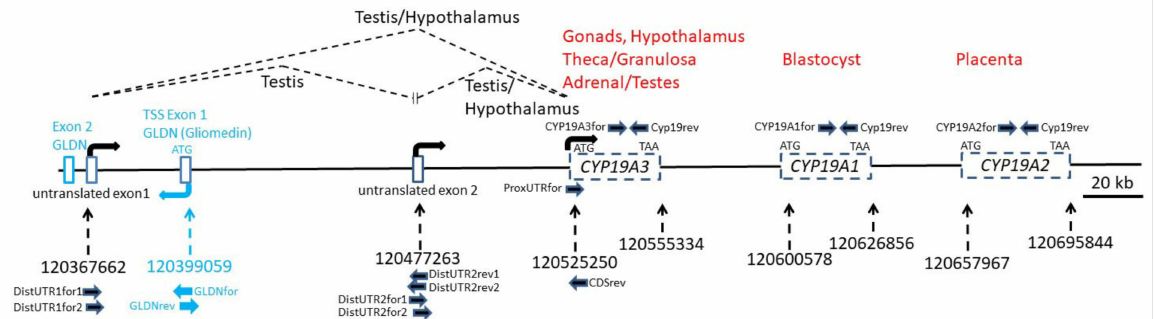
Figure 2. The pig CYP19 locus. The pig genomic region harboring the CYP19 locus and the first exon of Gliomedin ( GLDN ) was constructed by mapping published reference mRNA sequences of CYP19A1 (NM_214429), CYP19A2 (NM_214430) and CYP19A3 (NM_214431), sequences from hypothalamus and testis 5 ´ RACE clones and from RT-PCR products to the pig genomic contig NC_010443.5. Positions in NC_010443.5 are indicated with dashed arrows. Transcription start sites as indicated by RT-PCR experiments and positions of corresponding forward and reverse primers are indicated with arrows. Published sites of expression of the three CYP19 paralogs are shown in red (see also Table 1). Splicing of untranslated exons as found by RT-PCR experiments in testis and hypothalamus is indicated with dashed lines. Positions of untranslated exons of CYP19A3 and of coding exons within CYP19A1 , CYP19A2 and CYP19A3 are